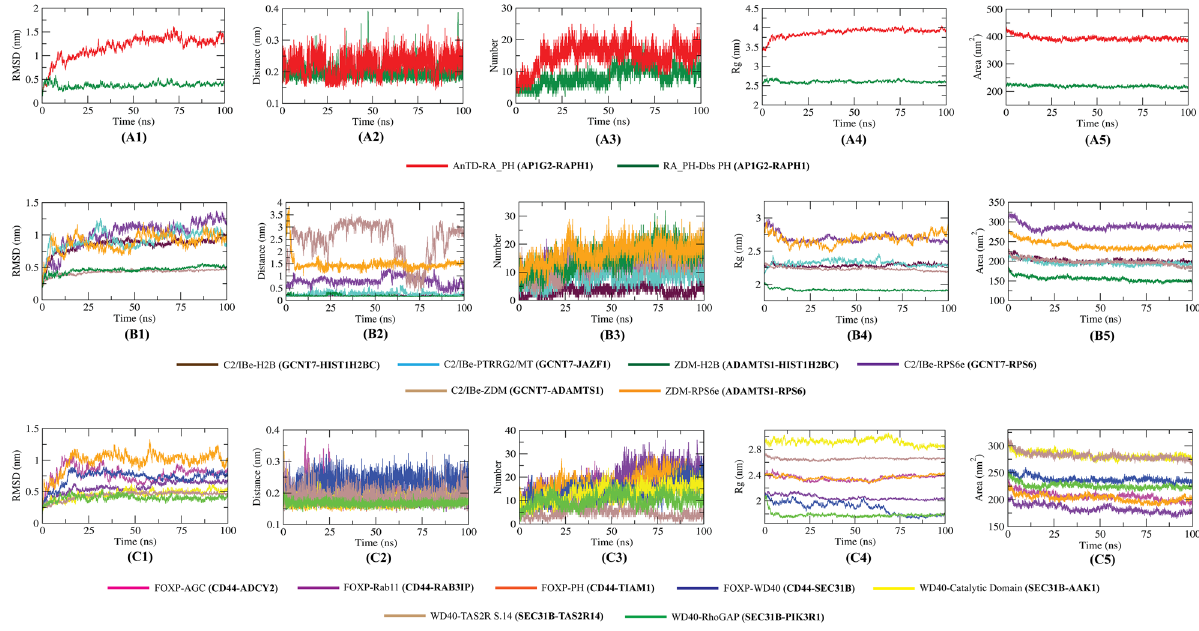
Figure 7. MD simulation results of protein complexes. The figure shows RMSD analysis ( A1 , B1 , C1 ), minimum distances in the interacting residues of the complexes ( A2 , B2 , C2 ), number of hydrogen bonds ( A3 , B3 , C3 ), Rg analysis ( A4 , B4 , C4 ), and SASA analysis ( A5 , B5 , C5 ).